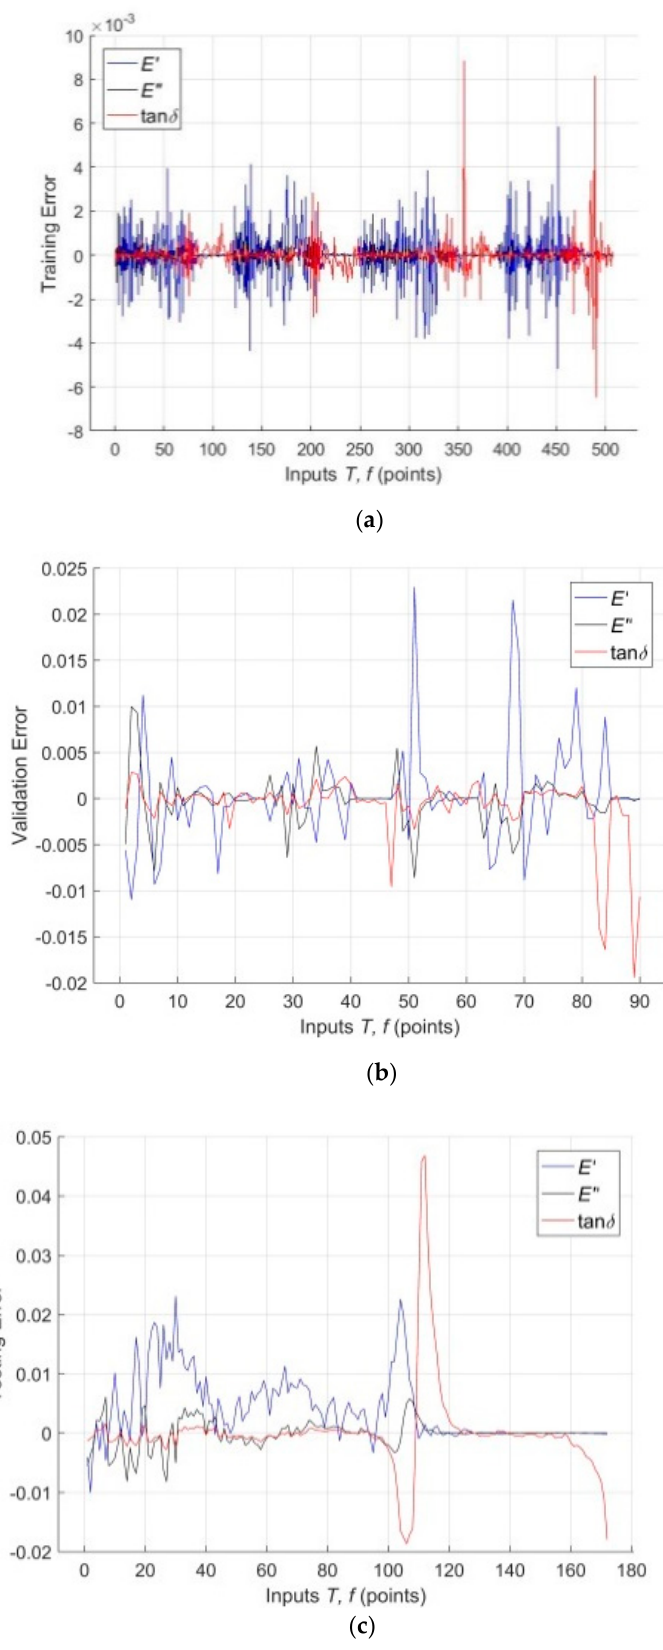
Figure 8. ( a ) Error plot for training data; ( b ) Error plot for validation data; ( c ) Error plot for testing data.